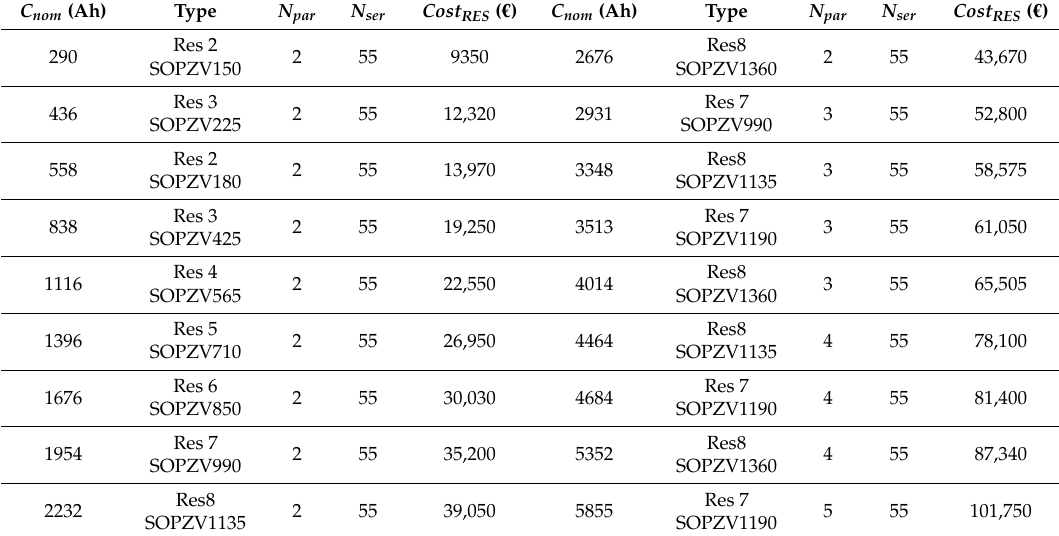
Table 7. Indicative 110 V Sunlight RES SOPzV battery system total cost Cost RES ( € ) and configuration (parallel branches N par and series elements N ser ) with respect to the total capacity C nom (Ah)